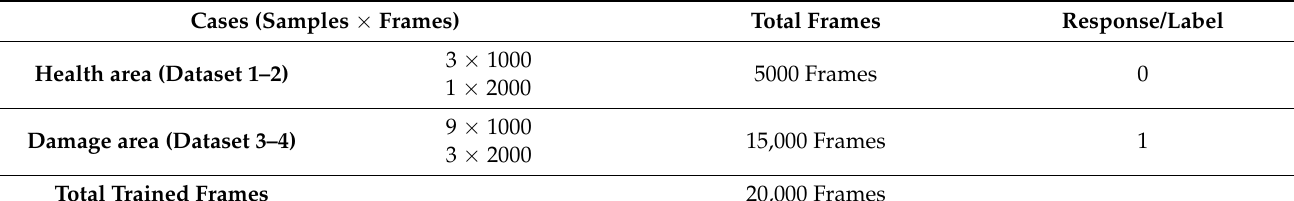
Table 10. Datasets categories representing thermal image